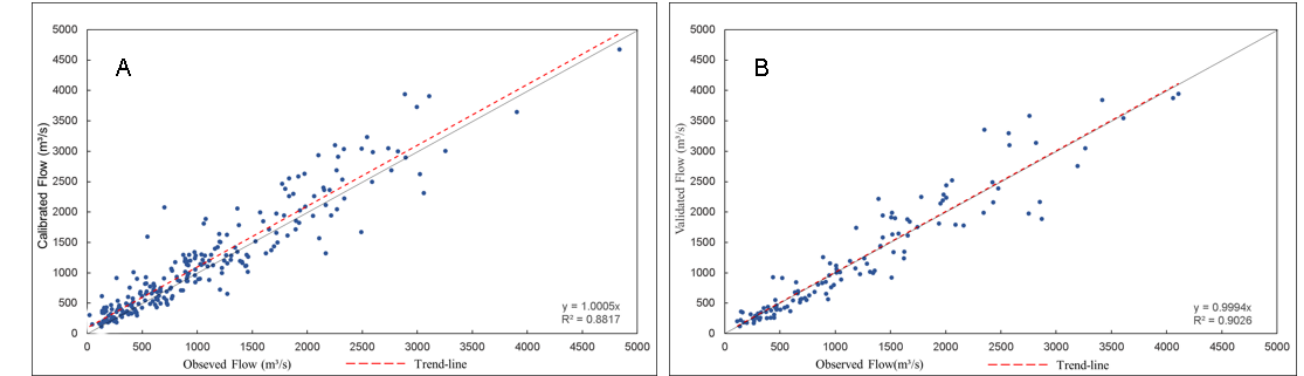
Figure 5. Dispersion of the simulated and measured flow (blue dot). Calibration ( A ) and validation ( B ).